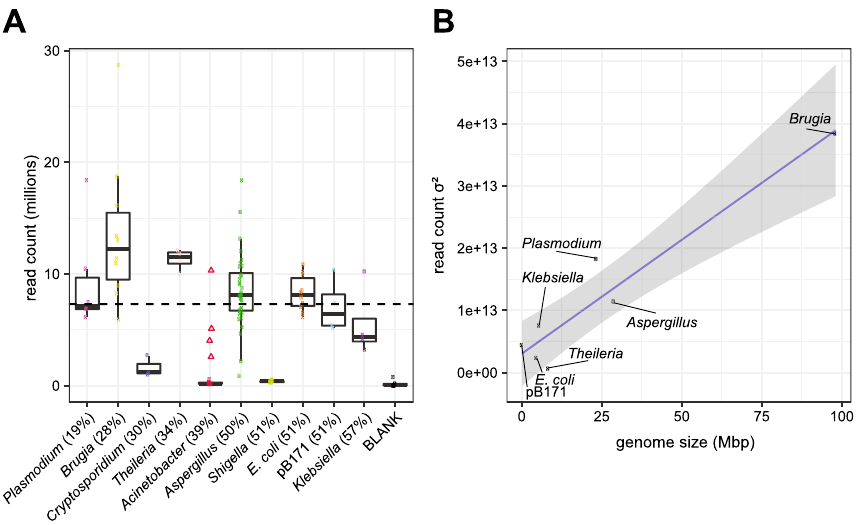
Figure 1. Riptide library read composition across study specimens. ( A ) Variability of sequencing throughput was assessed by examining the distribution of read counts per taxa. Members of a read pair were counted as two reads. Boxplots were drawn without outliers, and values from individual replicates are overlaid as colored dots. The red triangles shown without a corresponding boxplot denote four different Acinetobacter strains sequenced on a second Riptide plate (Supplementary Data S1). Specimens are organized along the x-axis by increasing genome GC content, which are shown in parentheses. The dashed horizontal line displays the expected 7.3 million read count per Riptide library by dividing the total sequencing throughput (654 million) by the number of Riptide libraries containing gDNA (89). ( B ) For each of seven species having consistent amplification of Riptide libraries, the variance (σ 2 ) of read counts was calculated assuming values represent entire populations.